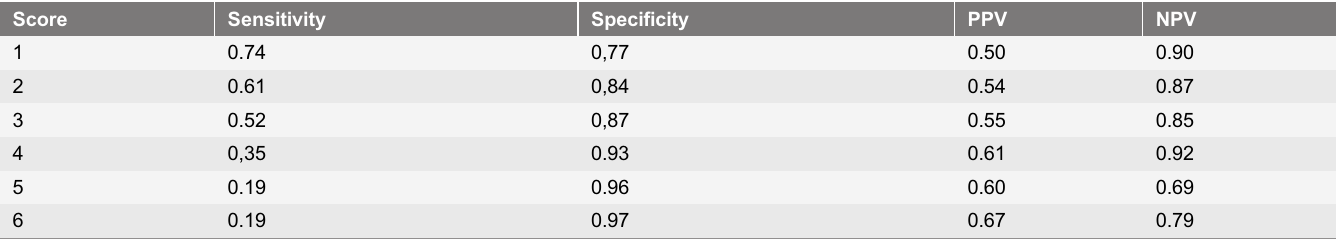
Table 2. Psychometric properties of the PHQ-2, by score